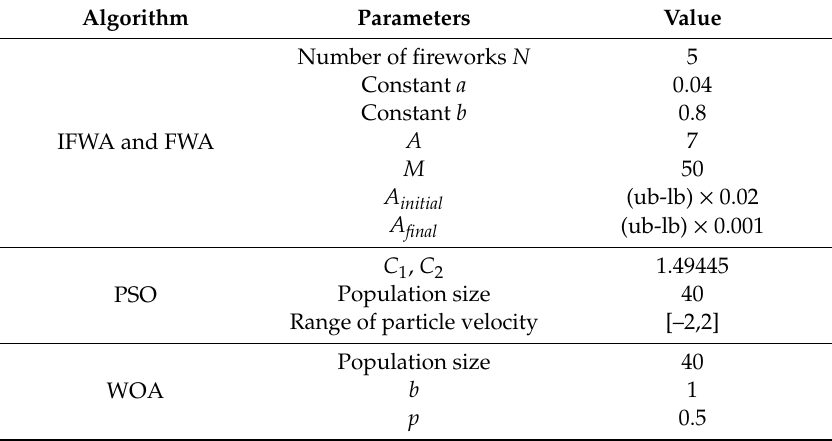
Table 2. Parameter settings in PFSP. IFWA: improved fireworks algorithm; PSO: particle swarm optimization; WOA: whale optimization algorithm. lb: lower bound; ub: upper bound.